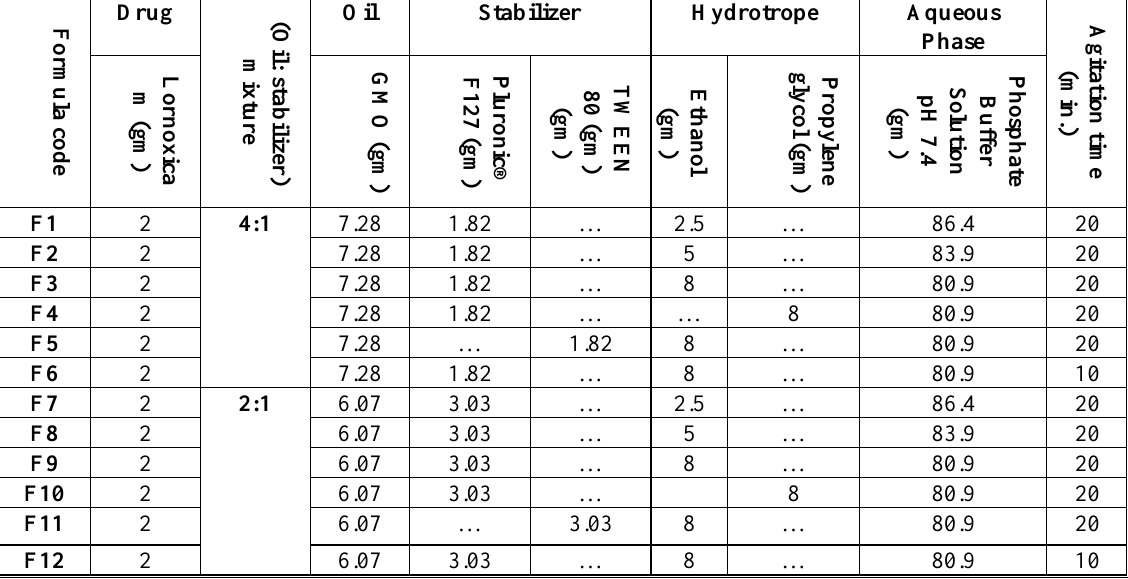
Table 1. Composition of LXM-loaded cubosomal